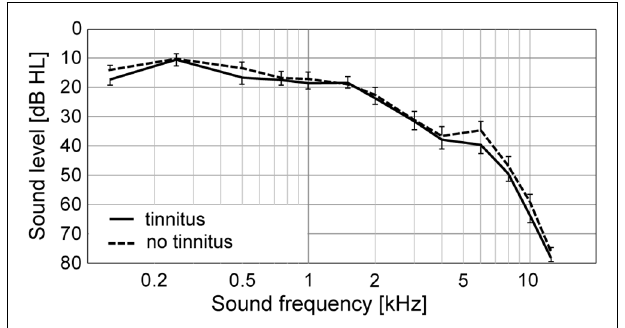
FIGURE 1 | Average pure-tone audiograms of the subjects with (T) and without (NT) tinnitus. Mean ± SEM.